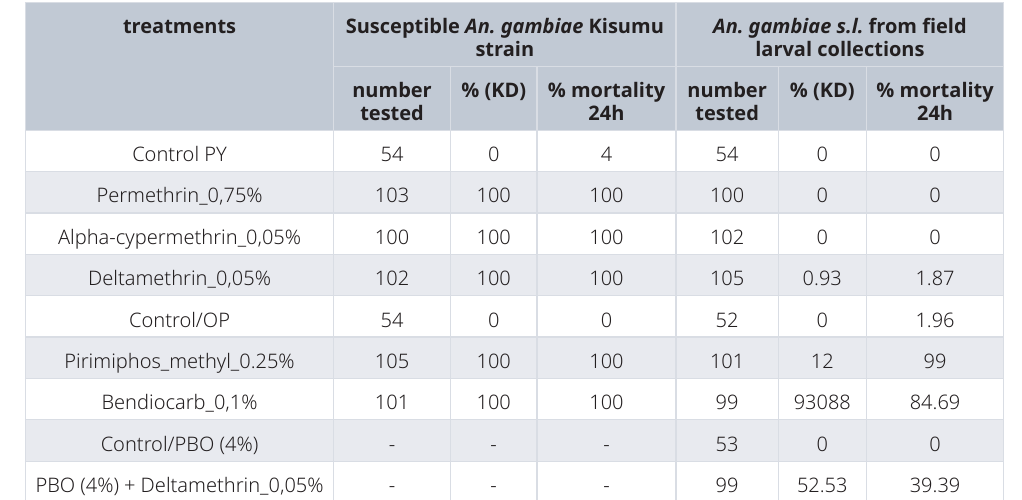
Table 5. WHO susceptibility assay results, Knock down and mortality of mosquitoes tested in World Health Organization (WHO) tube using impregnated papers to evaluate phenotypic